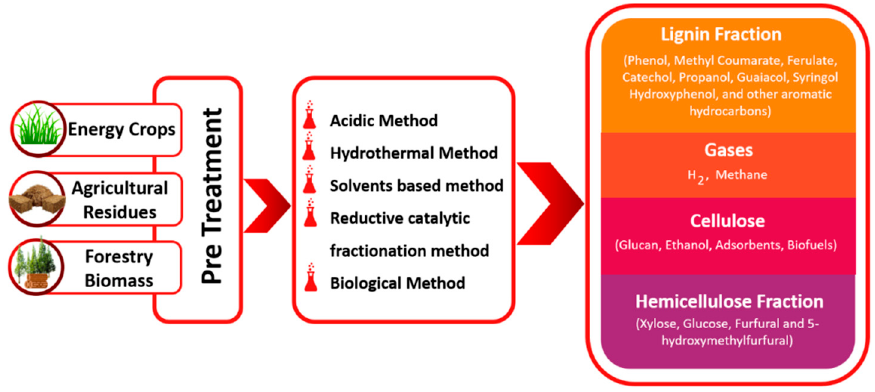
Figure 4. Feedstocks/products biorefinery with various pretreatments. Through hydrothermal pre-treatment (200 °C for 10 min) and enzymatic hydrolysis (cellulose enzyme), date palm fronds, jasmine hedges and Bermuda grass were succes- sively separated, resulting mostly in monomeric sugars at highly reduced cost of 0.59 USD/kg [119]. When compared to conventional procedures, the minimum selling price of the sugars produced was significantly higher, and the probable reason could be the re- duced efficiency of hydrothermal process to fractionate the lignocellulosic components or the on-site treatment of waste effluent. The research mentioned above thus supports the use of residual biomass from forestry and agriculture to offset the cost of the substrate. In a study by Berchem et al. (2020), a combination of feedstocks subjected to alkaline treat- ment resulted in slightly higher cellulose contamination than single feedstock pretreat- ments [120]. Additionally, higher-grade lignin was obtained by reducing protein and hemicellulose contamination. Woody biomass was effectively segregated into cellulose fibers, fermentable hemicellulose sugars and lignin employing complete and mild-condi- tion treatments rather than energy-intensive techniques. Lignin-derivable phenol-4-sul- fonic acid (PSA) was identified to have the potential to create a “closed-loop” fractionation